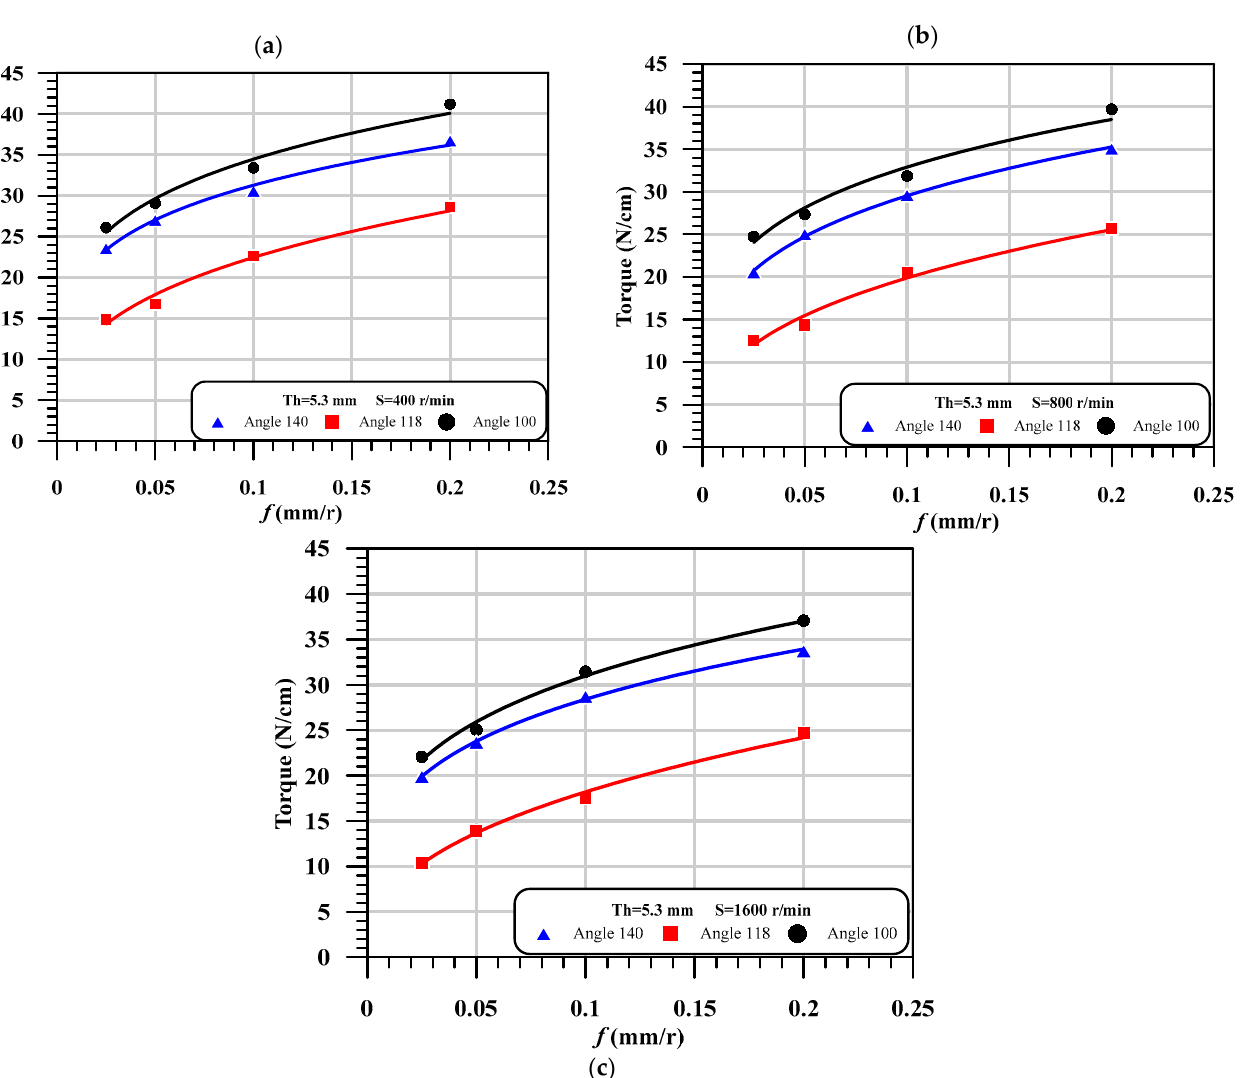
Figure 3. The effect of feed on the delamination factor with different point angles at different speed, ( a ) At thickness of 5.3 mm and speed = 400 r/min; ( b ) At thickness of 5.3 mm and speed = 800 r/min; ( c ) At thickness of 5.3 mm and speed = 1600 r/min.